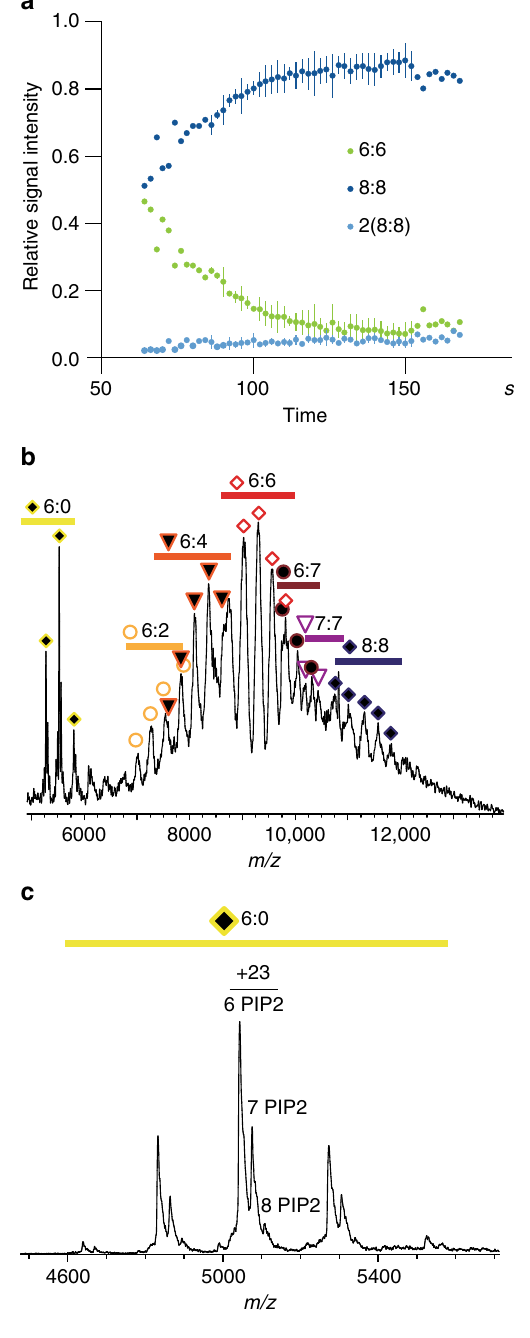
Fig. 5 Dynamics of ENTH/ANTH/PIP2 complex formation in fungi and human assemblies. a Time course of ENTH2/ANTH Sla2 /PIP2 ( S. cerevisiae ) complex formation. Components were mixed, injected into the electrospray capillary and the spectra monitored over time. Relative signal intensities for 6:6 (green), 8:8 (dark blue), and dimers of 8:8 complexes (light blue) were determined and plotted against time ( n = 3). The signal of the 6:6 complex drops within 2 min after mixing the complex components, while the signal of the 8:8 complex increases, suggesting a transition between these forms. The signal of the 8:8 dimer remains constant, ruling out aggregation effects. Average data of three independent measurements, error bars (standard deviation) are shown for data points with N = 3 b Native MS shows oligomerization of human epsin-1 ENTH and Hip1R ANTH in various stoichiometries, ranging from 6:0 to 8:8 with 6:6 being the main species. c molecules also in absence of